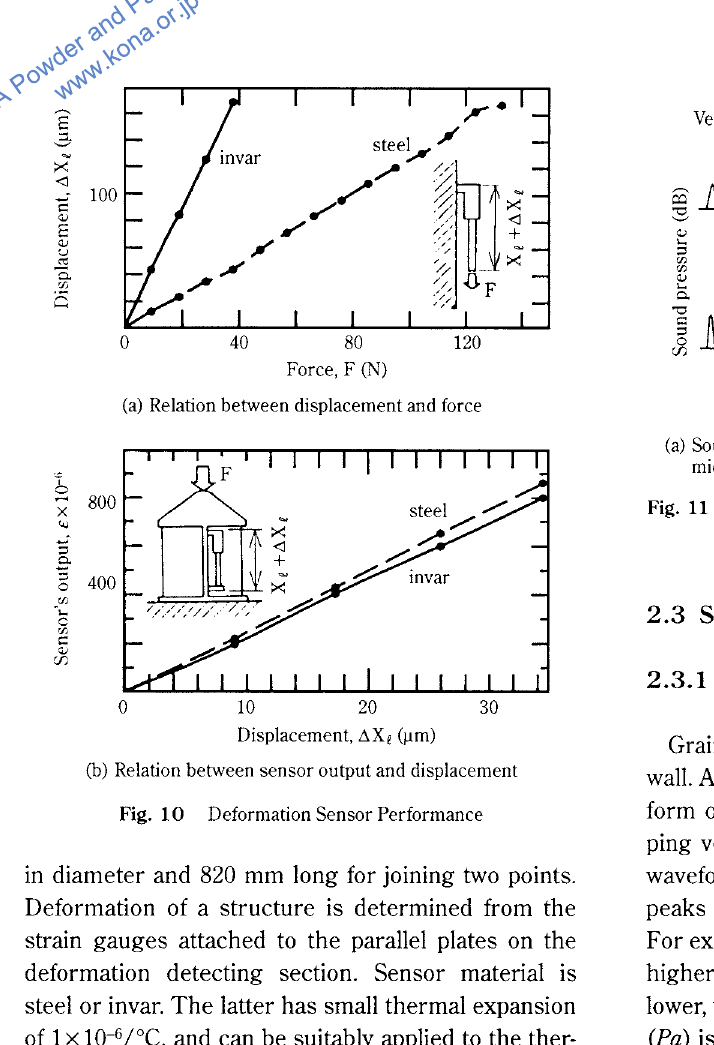
Fig. 11 Principle of Detecting Slipping Velocity by Sound Pressure Power